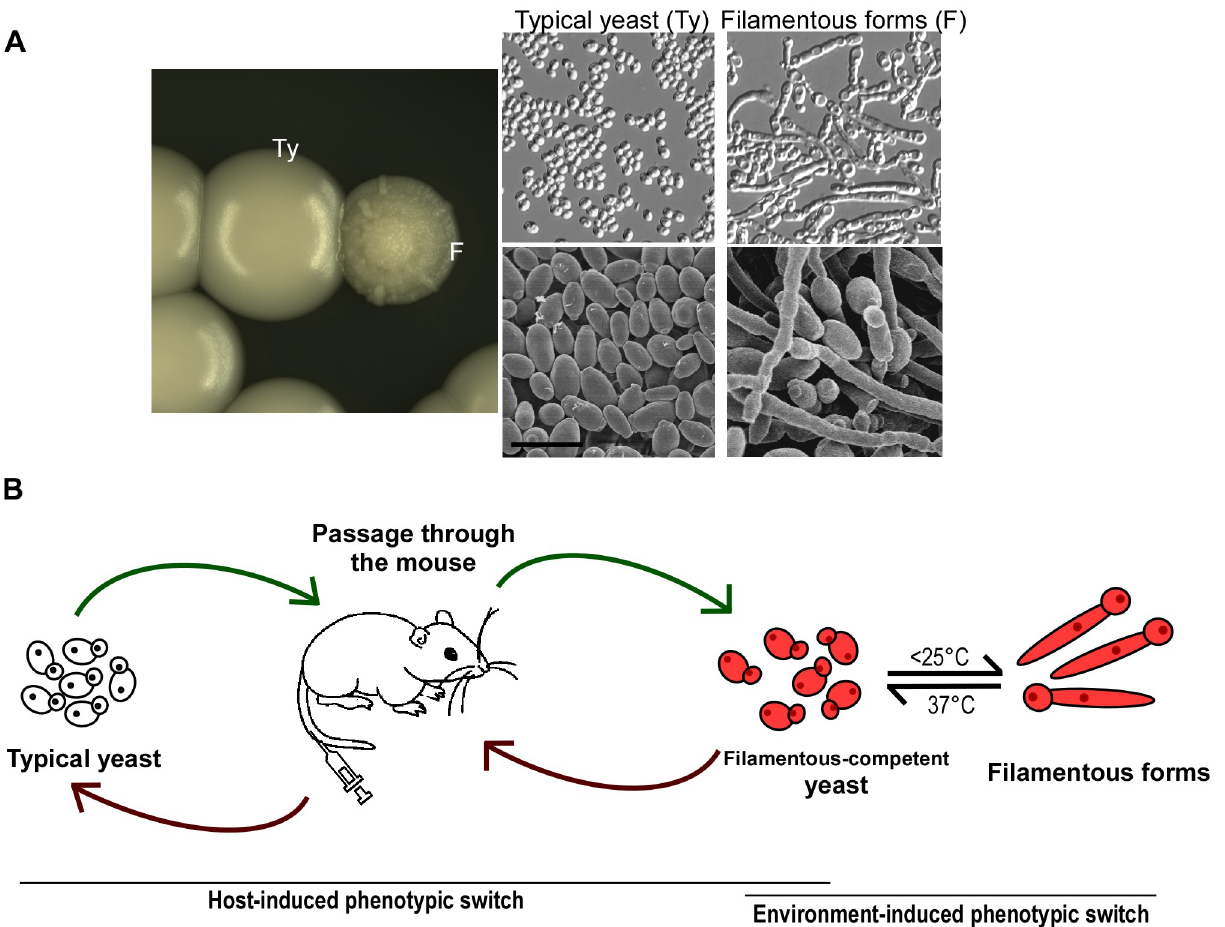
Fig 5. Morphological transitions in C . auris . (A) Colony and cellular morphologies of C . auris typical yeast form and filamentous-form phenotypes. Cells were grown on YPD medium. Images were adapted from [43]. (B) Known mechanisms for in vivo and in vitro phenotypic switching. Passage through the mouse mediates the switch between the typical yeast form and the filamentous competent yeast forms, whereas temperature mediates the in vitro switch between the filamentous competent yeast form and the filamentous forms. YPD, yeast extract peptone dextrose.